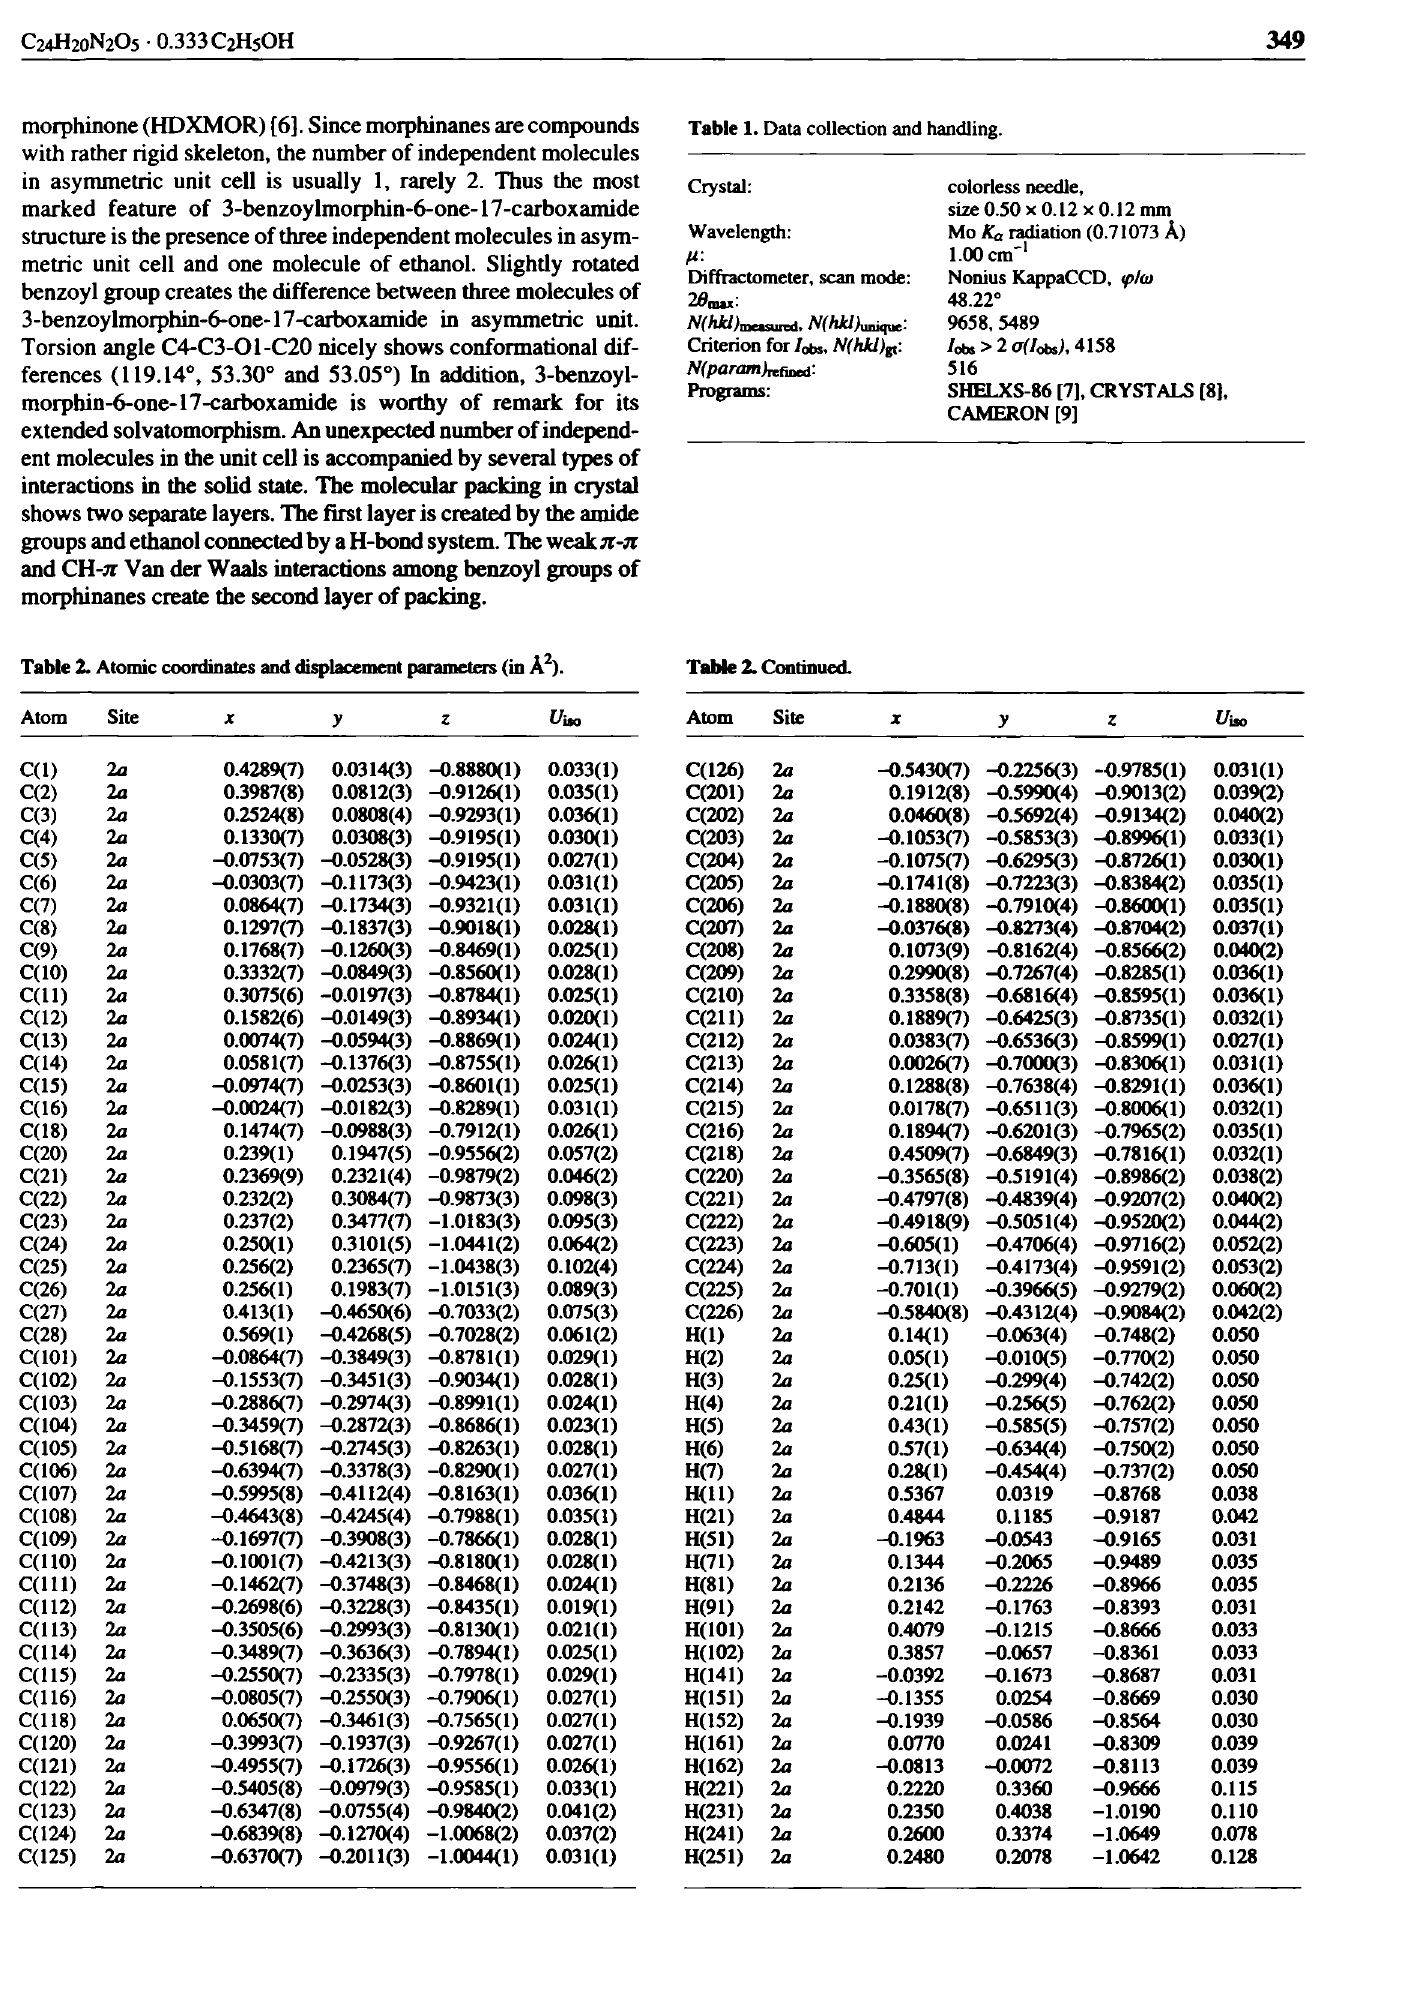
Table 1. Data collection and